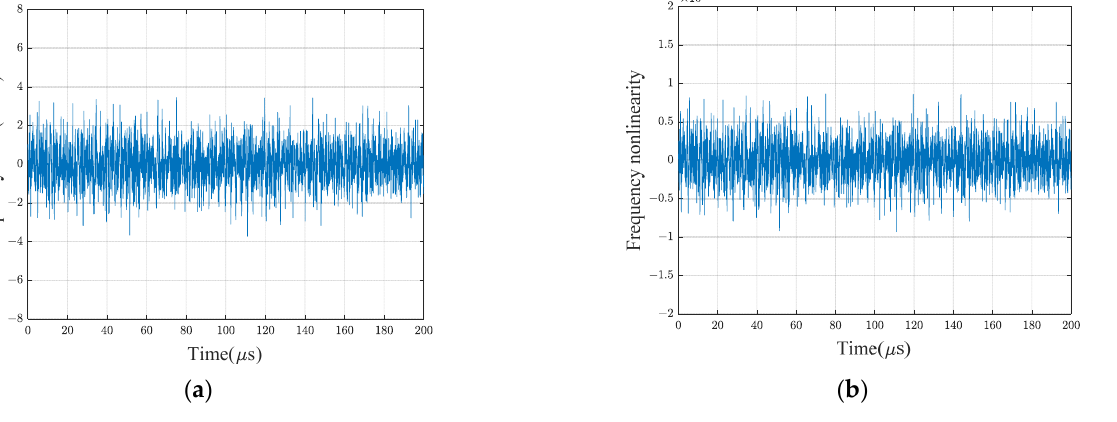
Figure 6. Frequency error analysis. ( a ) Frequency error of the LFM signals. ( b ) Frequency linearity of the mini-SAR.